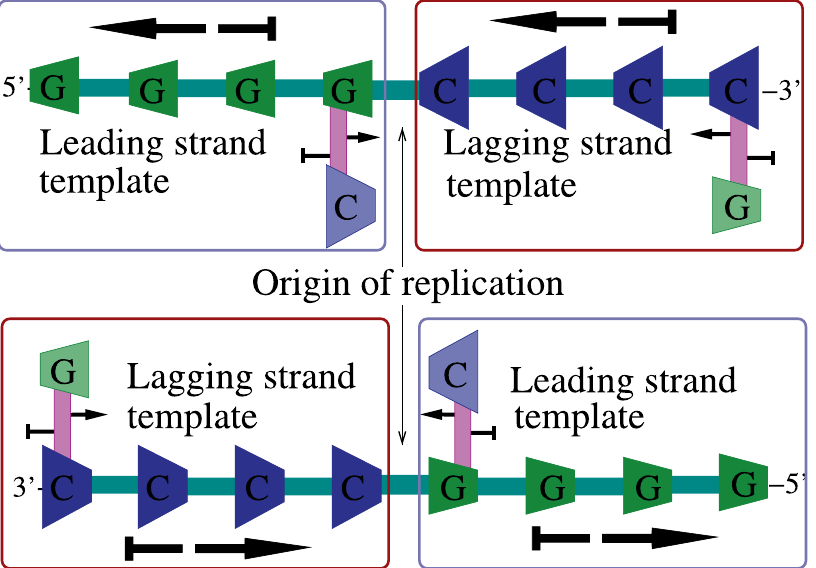
Figure 8. After the unzipping of a small section of anti-parallel DNA is complete, beginning from the “Origin of replication”, construction of the daughter strand begins on the exposed single strands. Sequence-independent asymmetric cooperativity dominates on single strands and the construction of daughter strand from the 3 ′ - end of the template is strongly kinetically favored. Sequence-dependent asymmetric cooperativity, denoted by the arrows attached to the base-pairs in the diagram above, are rendered ineffective due to the presence of the stronger sequence-independent part, denoted by the thicker arrows along the strands. As the double strand unzips towards the left and right from the origin with temperature fluctuations, the template strands enclosed within blue boxes would allow the replication to proceed smoothly, since their 3 ′ -end is located closer to the origin, from where the daughter strand construction begins and proceeds outwards, along the unzipping direction. These continously replicated template strands are termed “leading strand templates” in the biological literature. On the template strands where the direction of unzipping and the direction of daughter strand construction are opposite, as in the strands within the red boxes above, the daughter strand must necessarily be constructed discontinously. The construction can only begin after another burst of unzipping exposes enough single strand template, begins at the location farthest from the origin of replication at the 3 ′ -end, and proceeds towards the origin. These template strands are called “lagging strand templates”. Asymmetric cooperativity helps to rationalize the non-intuitive replication behavior as the kinetically favorable option for DNA to replicate itself, through temporal parallelization of